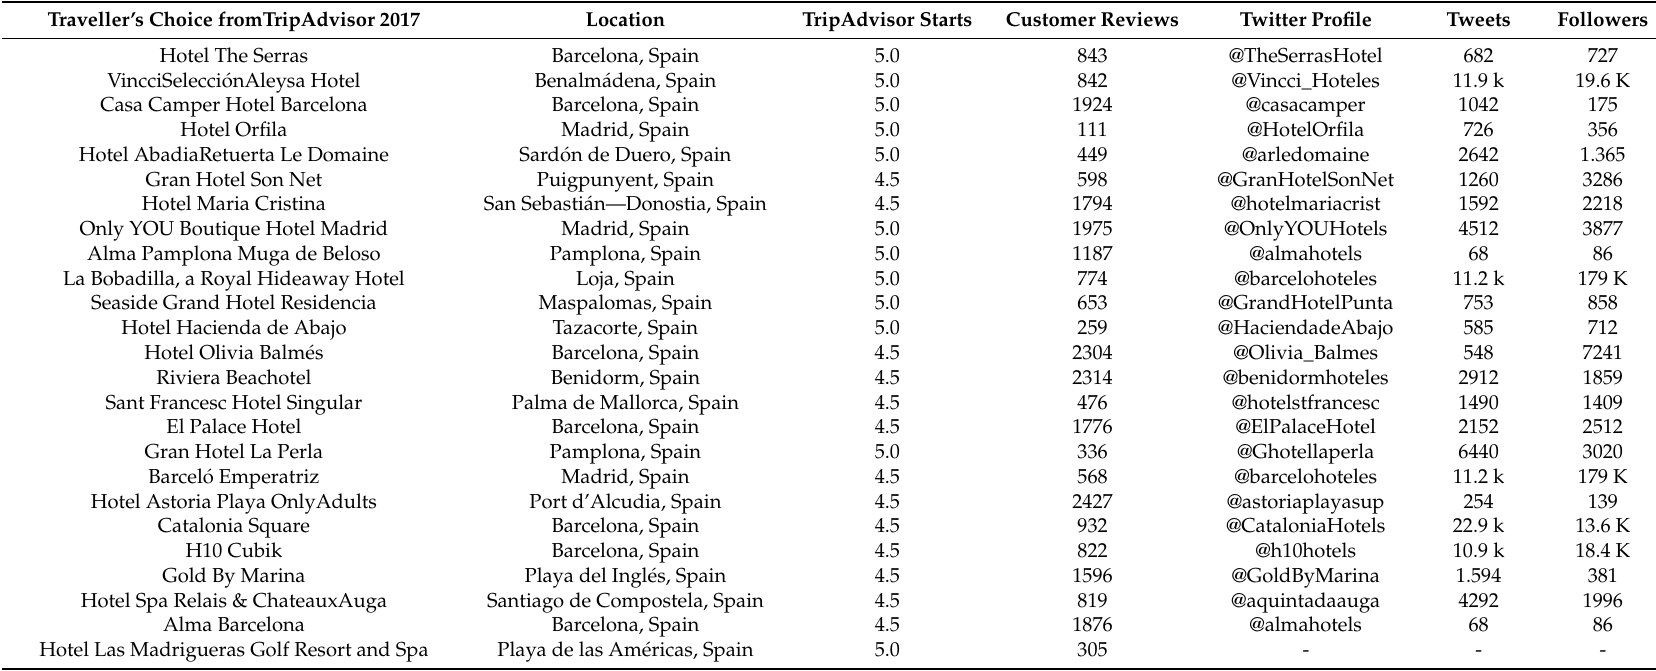
Table A1. Winning traveler’s choice hotels from TripAdvisor sample in